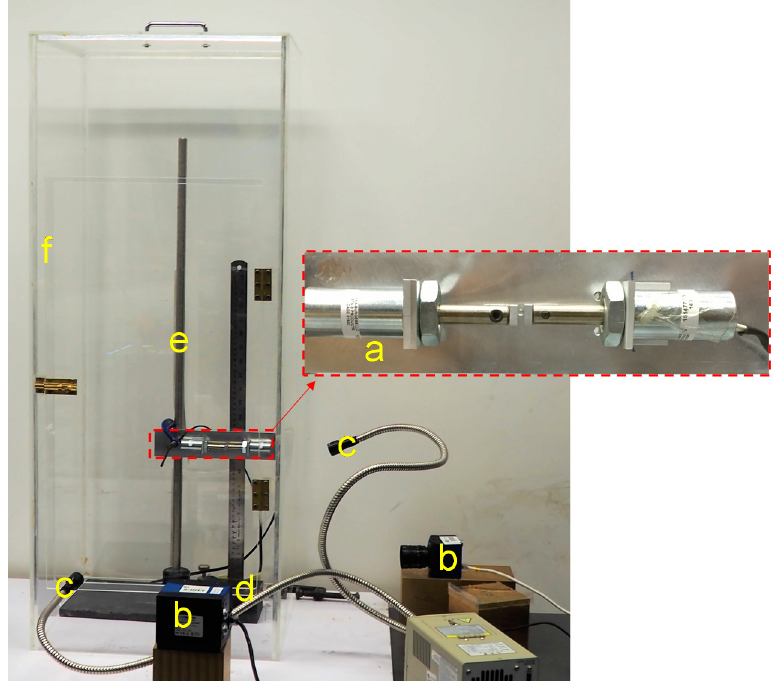
Figure 1. An image of the micromechanical impact apparatus (a) solenoids holding glass ball before the drop test (b) high-speed cameras (c) focused LED’s (d) base plate (e) cantilever pole to adjust height of drop (f) Perspex chamber.